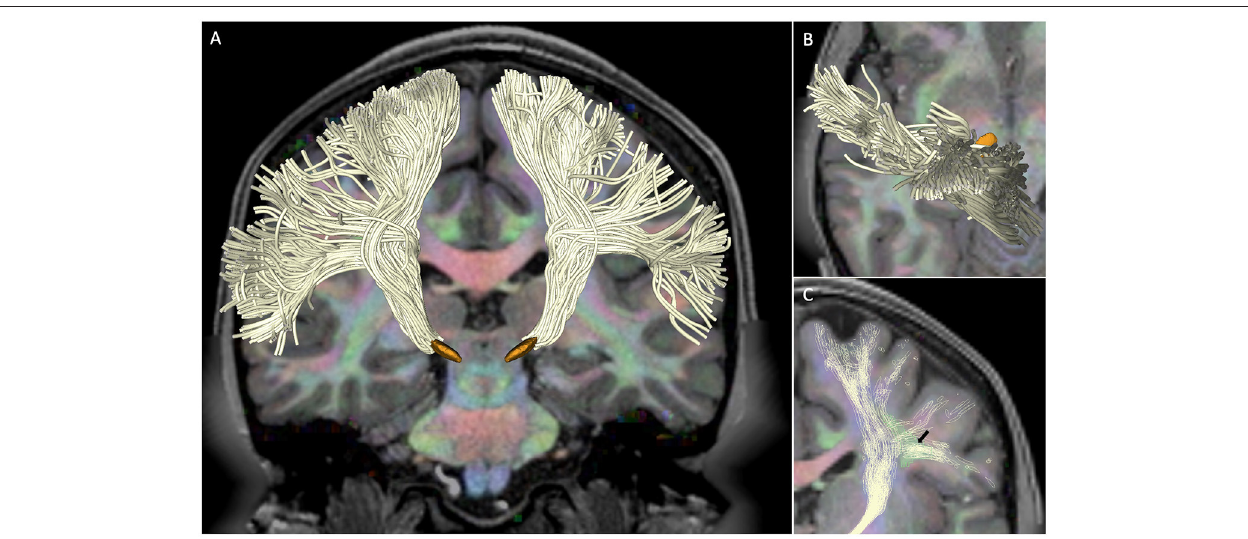
FIGURE 1 | Hyperdirect pathway in subject 100307. The figure shows the tractography reconstruction of hyperdirect pathway fibers projecting from the primary motor cortex to the subthalamic nucleus. The tracts (white) are displayed on a diffusion encoded color map overlaid on a T1-weighted image with 3D models of the subthalamic nucleus (orange) for anatomical reference. (A) Anterior 3D view of the hyperdirect pathway. (B) Superior 3D view of hyperdirect pathway fibers descending from the primary motor cortex. (C) Anterior 3D view of the crossings of hyperdirect pathway fibers with the superior longitudinal fasciculus. The arrow points at the intersection of lateral projections of the hyperdirect pathway with a cross-section of the superior longitudinal fasciculus